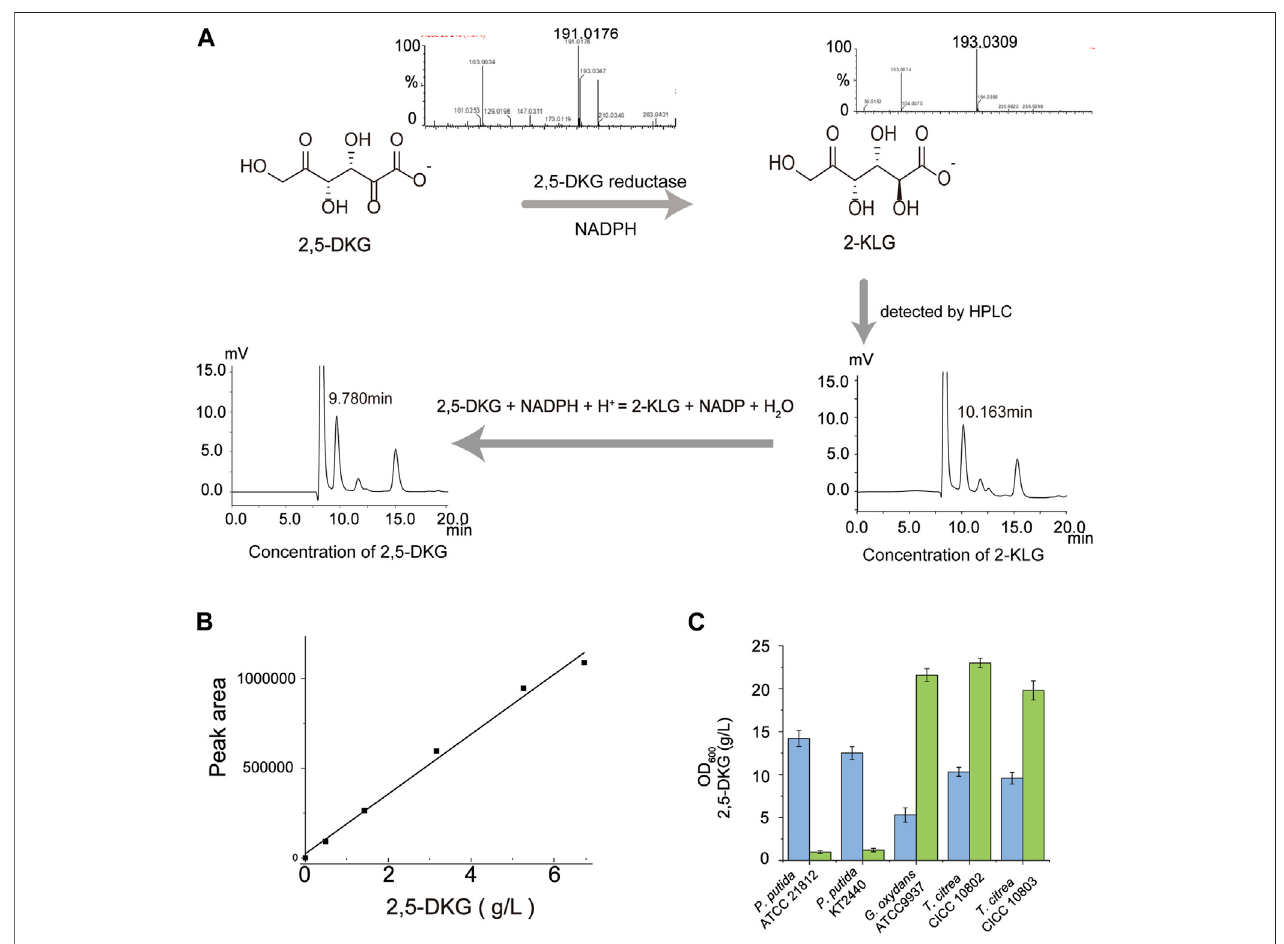
FIGURE 1 | Quanti fi cation of 2,5-DKG by indirect HPLC analysis. (A) The peak time of 2,5-DKG is different from that of 2-KLG in HPLC detection. Therefore, 2,5- DKG which is dif fi cult to quantify can be transformed into 2-KLG which is easier to quantify, and the real concentration of 2,5-DKG can be calculated from the concentrationof2-KLG. (B) Standard2,5-DKGcurve. (C) Comparing2,5-DKGproductionindifferentstrains. P.putida ATCC21812(Noproduction); P.putida KT2440 (No production); G. oxydans ATCC 9937 (21.6 g/L); T. citrea CICC 10802 (23.6 g/L); and T. citrea CICC 10803 (19.8 g/L). Blue = OD 600 ; green = 2,5-DKG concentrations.